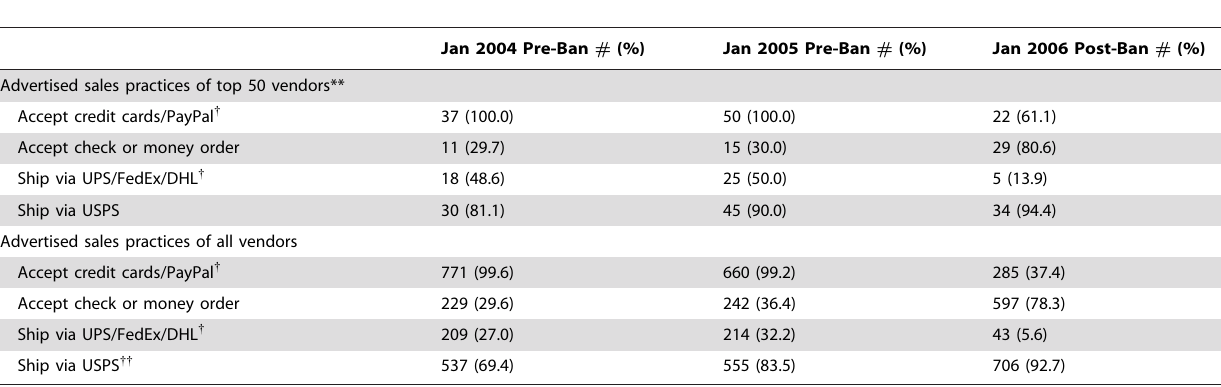
Table 1. Advertised payment and shipping practices of Internet cigarette vendors before and after the 2005 credit card and shipping